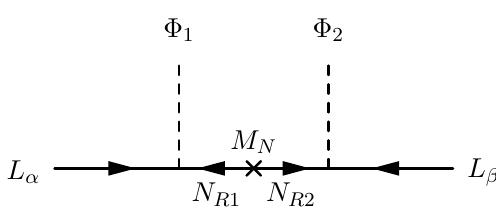
Figure 1 . The type Ib seesaw mechanism involves two different Higgs doublets Φ 1 and Φ 2 . The minimal model involves two right-handed neutrinos N R1 and N R2 which form a Dirac mass M N